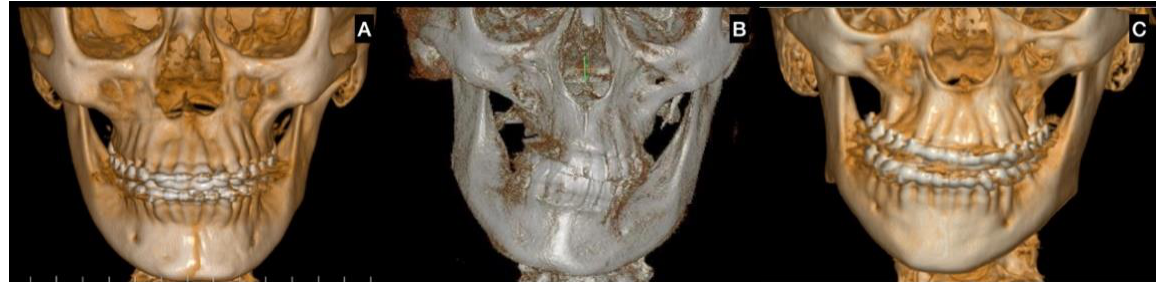
Figure 2. Classification of the facial asymmetry related to unilateral condylar hyperplasia. ( A ) type 1, with a horizontal component with UCH on the right side; ( B ) type 2, with a vertical component with UCH on the left side; ( C ) type 3, with a horizontal and vertical component and UCH on the left side.